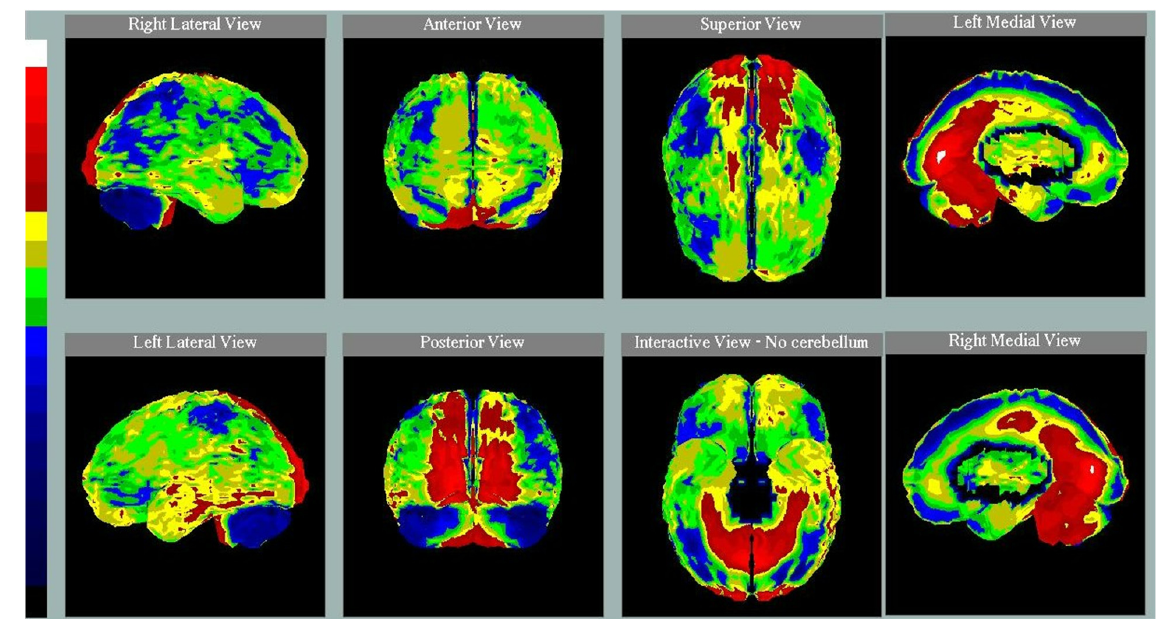
Figure 1. Hypoperfusion in Brodmann areas 20R, 24R, 32R, 45R (right inferior temporal cortex, right ventral and dorsal anterior cingulate cortex, and right inferior frontal gyrus—triangular part) was associated with a higher anosognosia total score.